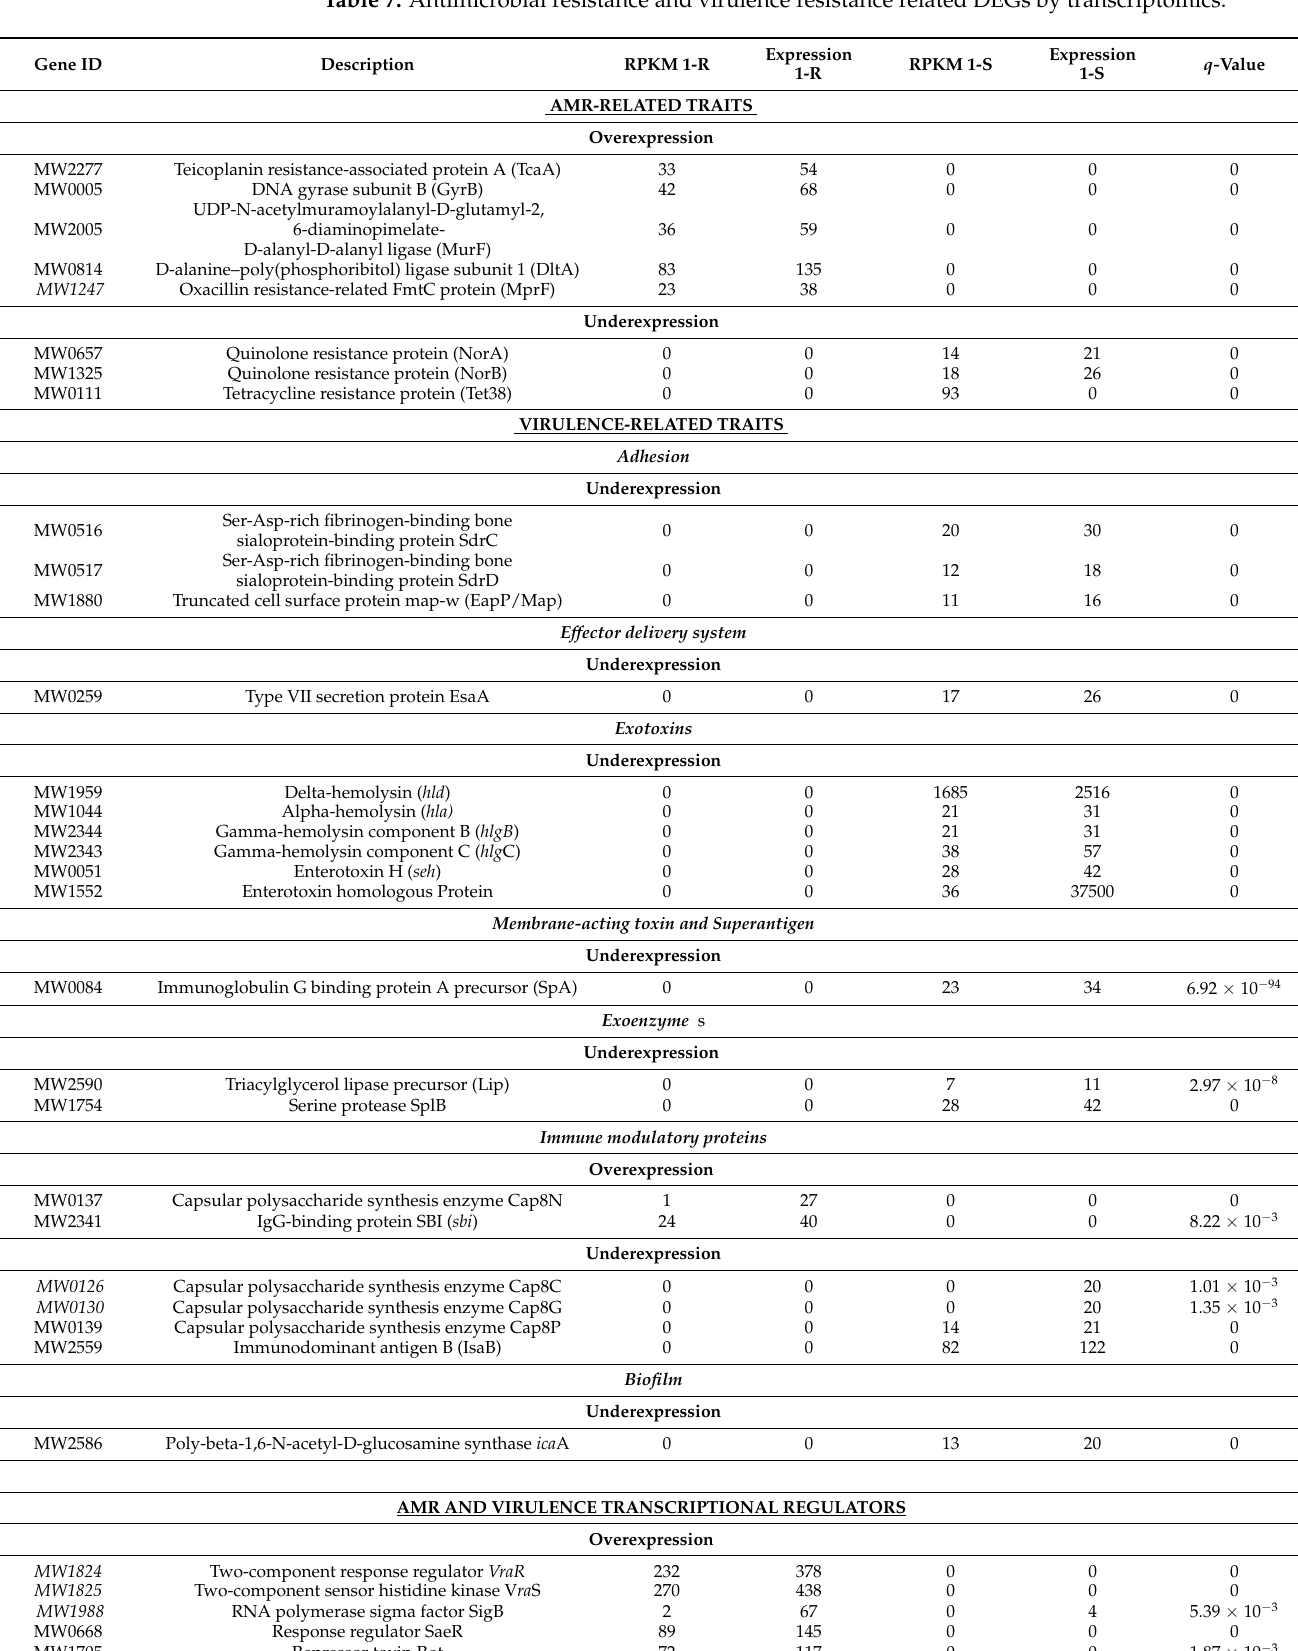
Table 7. Antimicrobial resistance and virulence resistance related DEGs by